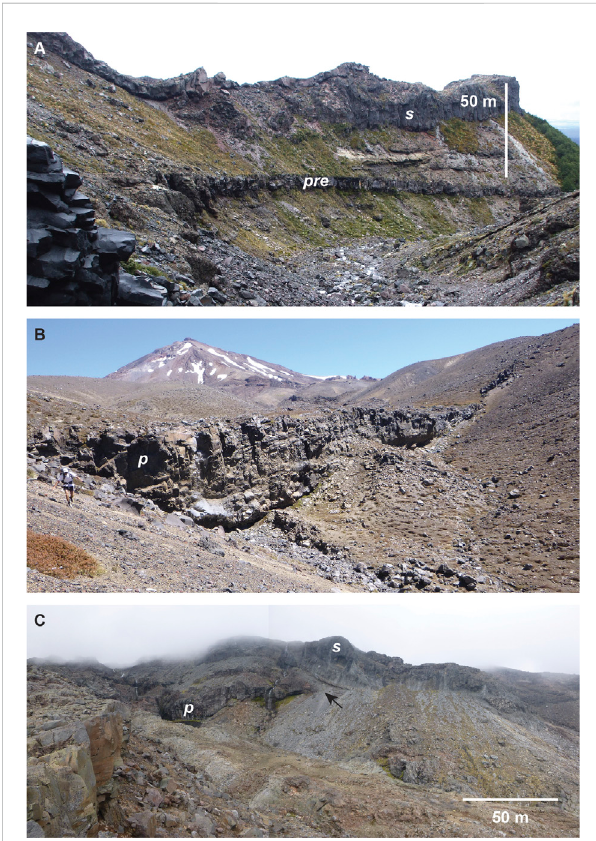
FIGURE 5 Stratigraphic features of pre-, syn-, and post-glacial lava lavas (pre, s, p) at Mount Ruapehu, New Zealand. (A) The syn-glacial lava exhibits a thick and uneven morphology, and is younger than the lowerpre-glaciallava,whichisauniformlythinunitthathasbeen eroded by glacial (and fl uvial) action. (B) This post-glacial lava fl owed into the valley and was not ponded along the ridge. (C) The post- glacial lava is younger than the syn-glacial lava in this photo. Although it looks like (p) is outcropping from beneath (s) at the location marked bythearrow,thepost-glaciallava fl owedintothevalleyafterretreatof the ice that buttressed the syn-glacial